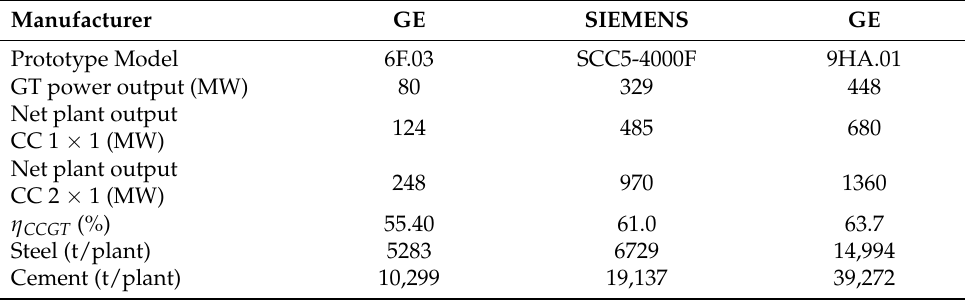
Table 3. Key performances of typical gas turbines and CCGT